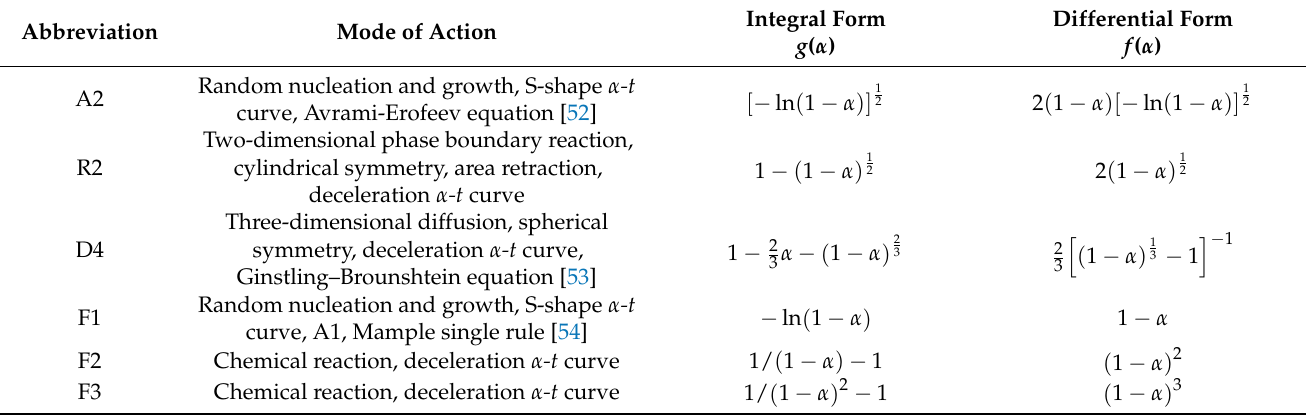
Table 4. Reaction functions in thermal kinetics analysis